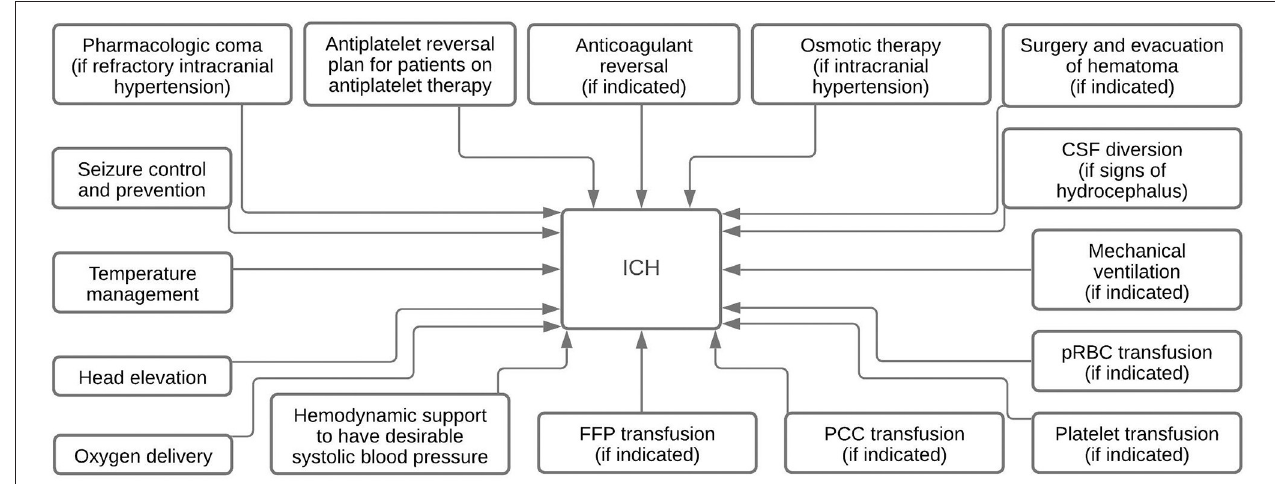
FIGURE 1 | Summary diagram depicting various ICH treatment